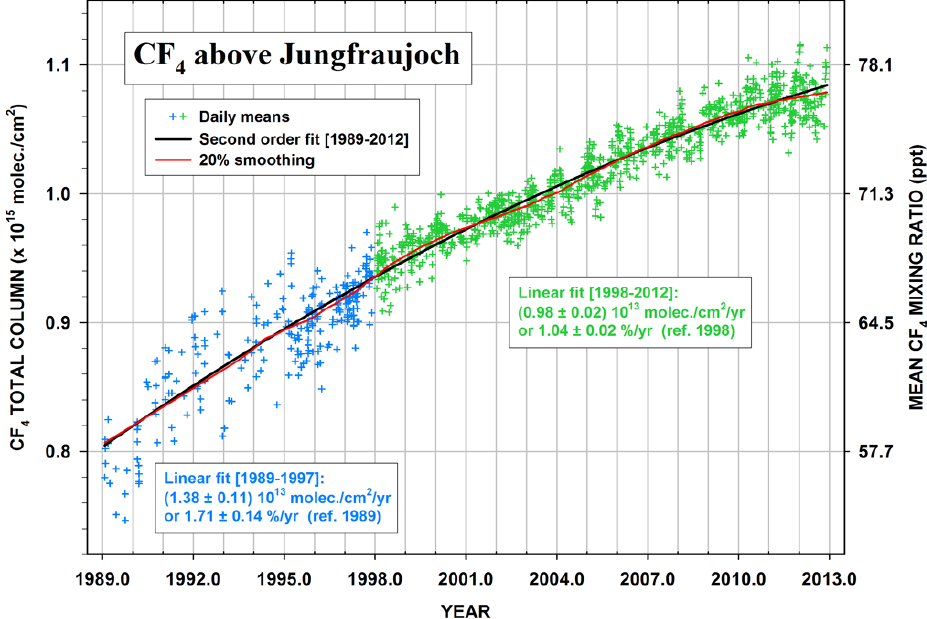
Fig. 2. FTIR time series of CF 4 daily mean vertical column abundances above the Jungfraujoch (expressed in numbers of CF 4 molecules per squarecm), normalized to a mean local pressure of 654hPa. The solid black and red curves correspond to a second order fit and a 20% smoothing function to the data points, respectively. The coefficients of the second order black curve are (from the highest order to the independent term): − 0.0194, 78.72 and − 79835, in units of 10 13 moleccm − 2 . In the same units and rank, the coefficients of the linear regression are 1.385, − 2675 and 0.979, − 1862, for the 1989–1997 (blue) and 1998–2012 (green) time periods, respectively. The right side scale corresponds to the conversion of our measured columns into mean constant mixing ratios above the site, expressed in ppt (parts per